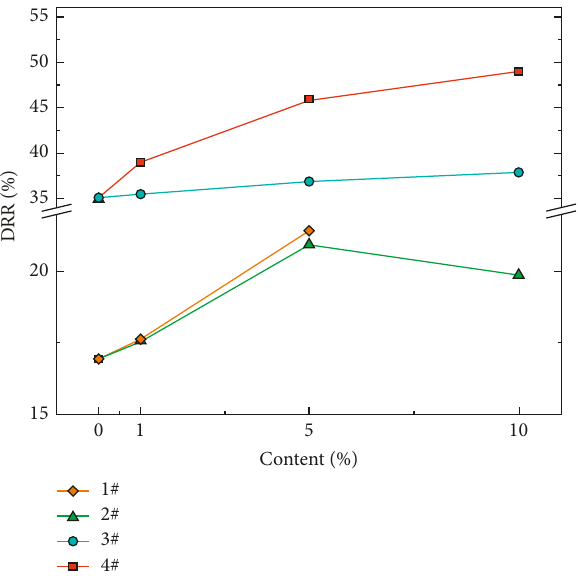
Figure 6: Ductility retention rate of different